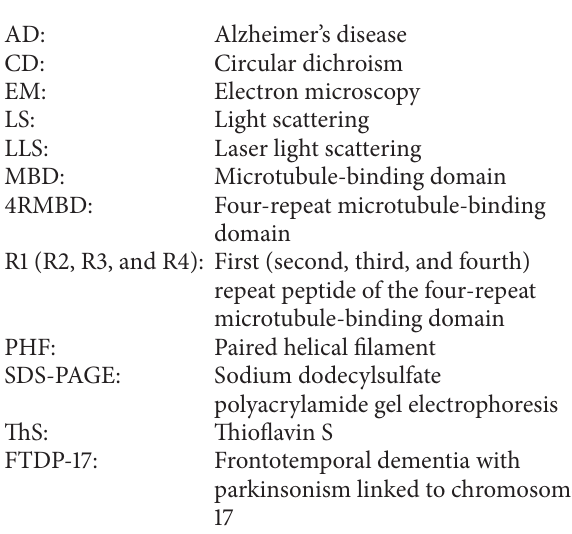
FtsZ: Filamentation temperature-sensitive protein